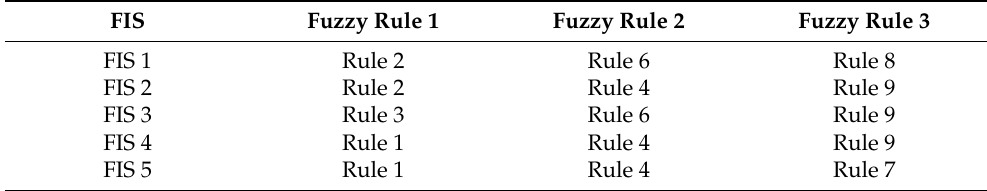
Table 5. Optimized fuzzy rules for each used FIS (Table 2).